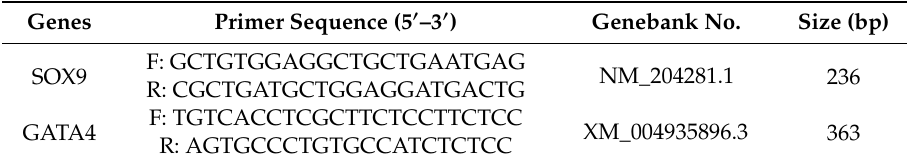
Table 1. Gene primer